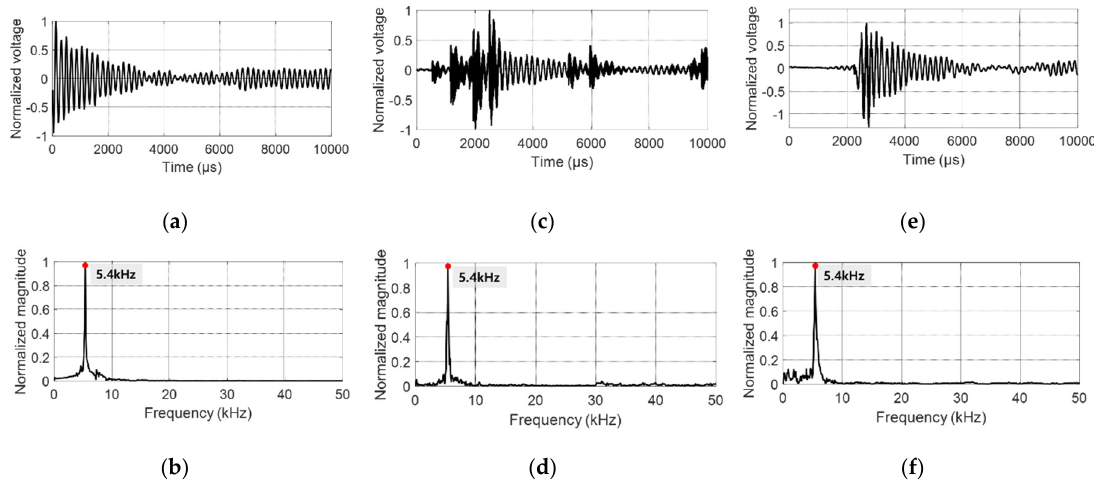
Figure 7. Obtained signals from the shallow delamination. Steel ball impactor ( a ) time signal and ( b ) frequency spectrum. 11-tooth gear ( c ) time signal and ( d ) frequency spectrum. 30-tooth gear ( e ) time signal and ( f ) frequency spectrum.